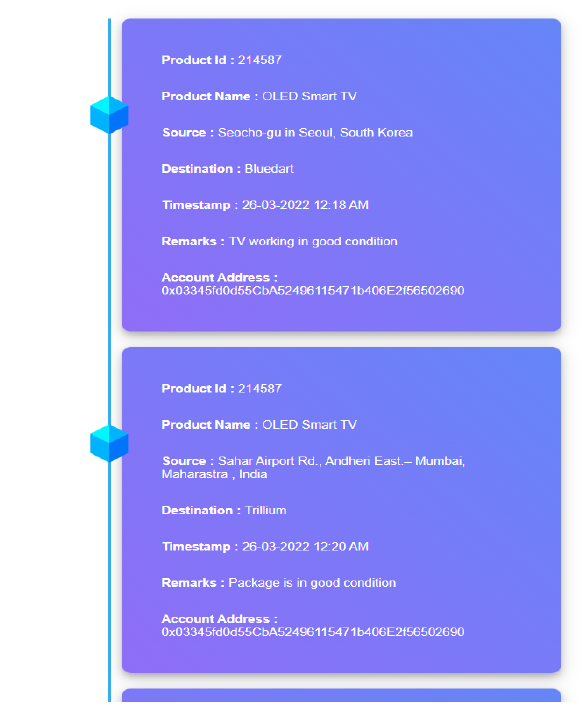
Figure 16: Supply chain history - 1.